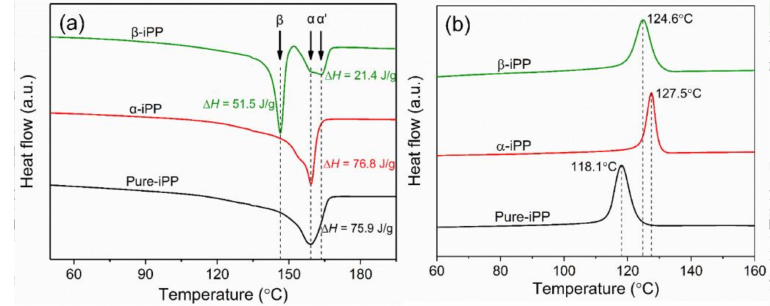
Figure 5. DSC results of iPP samples. ( a ) Melting curves and ( b ) crystallization